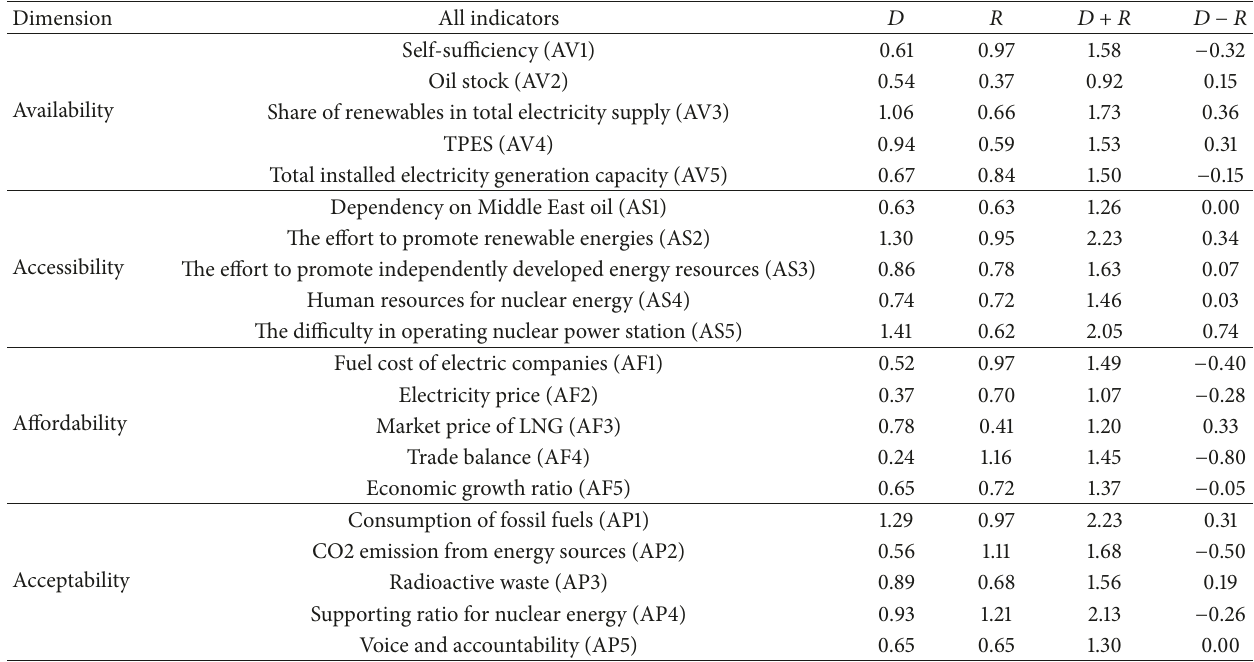
Table 15: The result of Fuzzy-DEMATEL analysis for all indicators of energy security (Case 3